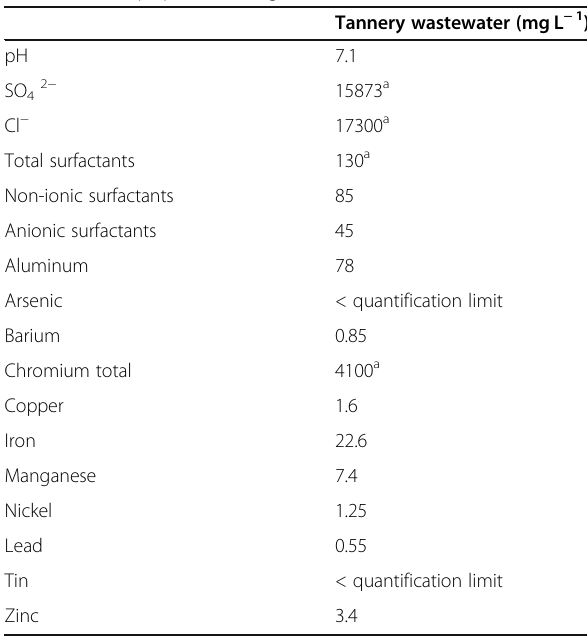
Table 1 Results of the analysis of tannery wastewater as received. (Except pH, all in mg L − 1 )